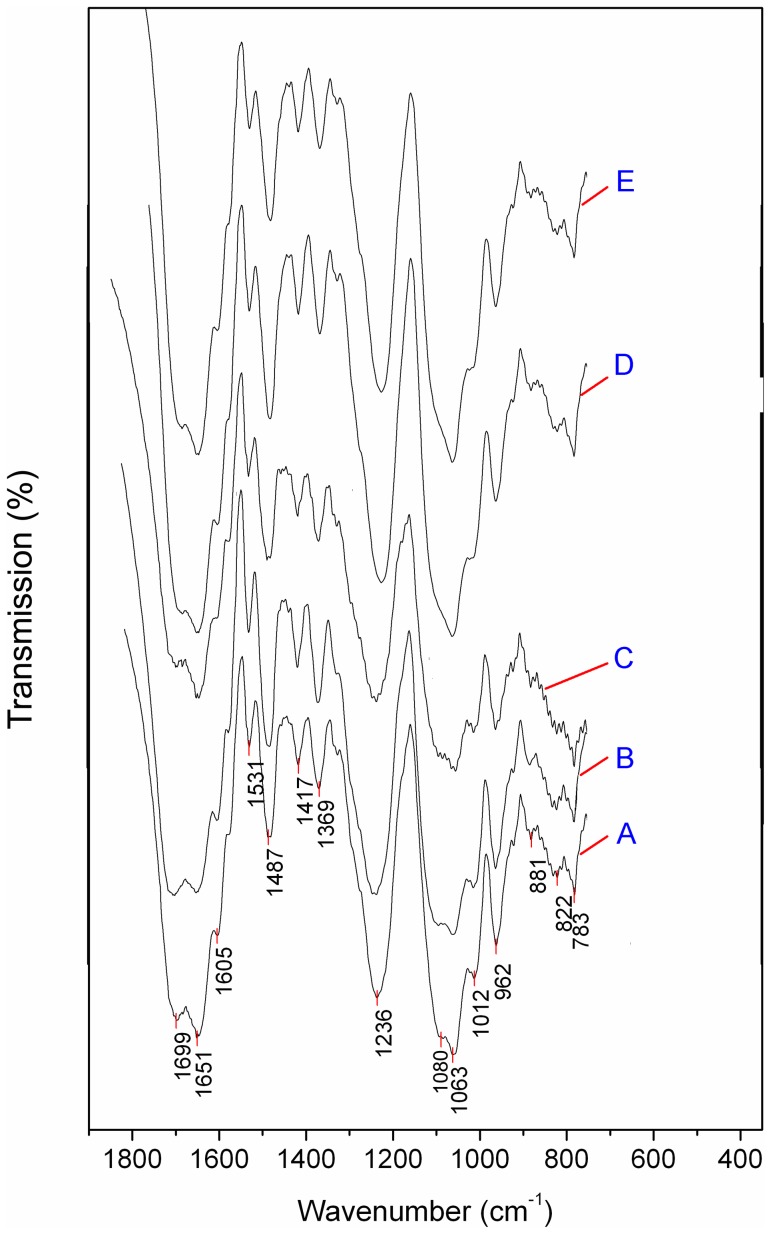
The FTIR spectra for DNA (A), DNA–phenanthrene (B), DNA–pyrene (C), DNA–phenanthrene-Ca (D), and DNA–pyrene-Ca (E).In (D) and (E), the peak at 1080 cm–1, which was related to the symmetrical stretch vibration of phosphate functional groups (PO2
––O–CH2), disappeared, indicating the production of hydroxy calcium phosphate by electrovalent bonds.